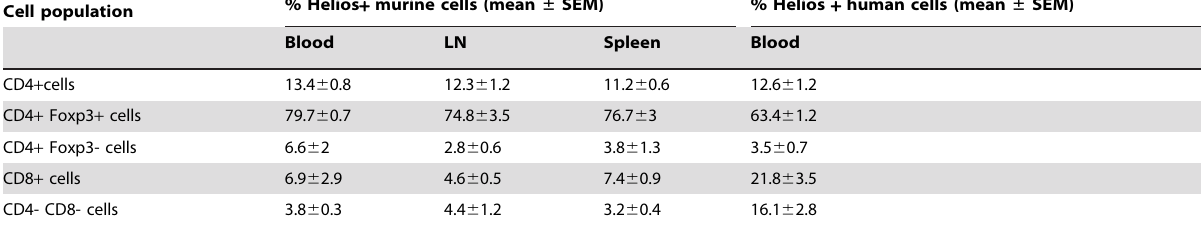
CD4 + , CD8 + and CD4-CD8- cells expressed Helios, with CD4 + Foxp3 + Treg showed the highest Helios expression in both species ( Table 1 ). There were no gender-based differences in Helios expression when tested using age-matched samples (data not shown). In mice, Helios + T cells from lymph nodes and spleen were more likely to co-express Foxp3 and CD25 than PBMC ( Figure 1A ). In human CD4 + cells, the highest levels of Helios expression were associated with Foxp3, CD25, CD39, CTLA-4 (CD152) and low levels of CD127, while intermediately positive Helios + cells included non-Treg cells ( Figure 1B ). Importantly, CD4 + Helios + and CD4 + Helios- cells expressed CD31, a marker of recent thymic emigrant cells, almost equally ( Figure 1B ). Together, these data suggest that Helios might not be a specific marker of nTreg cells.